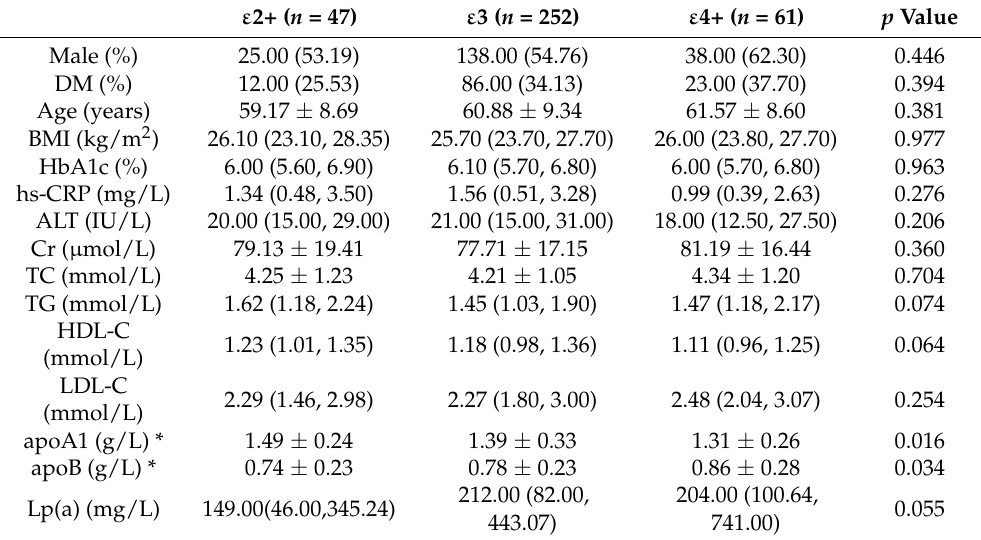
Table 1. The baseline characteristics of 360 patients grouped by APOE